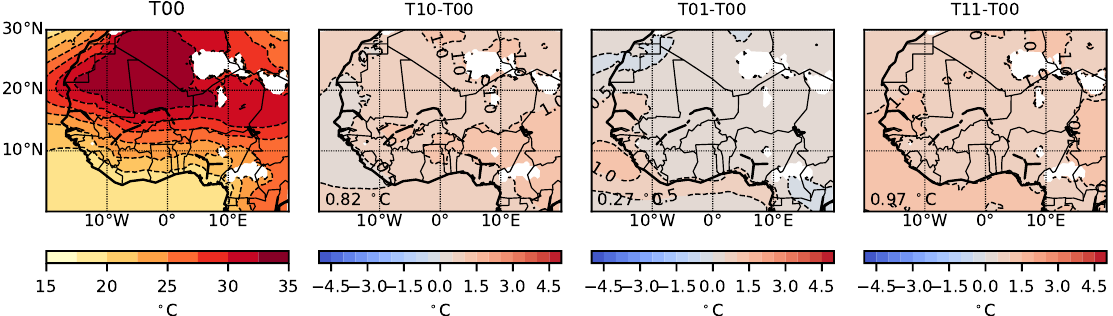
Figure A2. JAS 925 hPa temperature for the control simulation and sensitivity experiment anomalies.